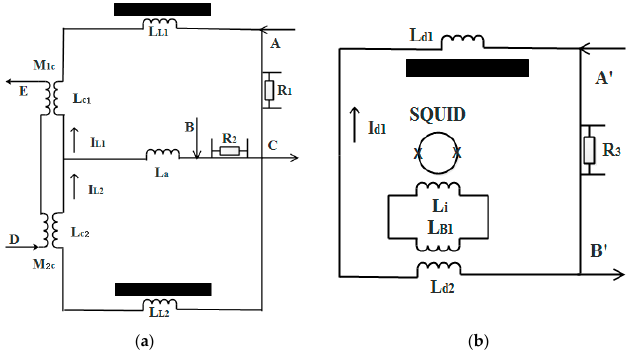
Figure 5. Superconducting circuits for the sensitive degree of freedom. ( a ) The levitating circuit and ( b ) the test mass displacement detecting circuit. The heat-switches R 1 and R 2 and the current injecting ports A, B, and C are used to inject and adjust the levitating currents; mutual inductions M 1c and M 2c and